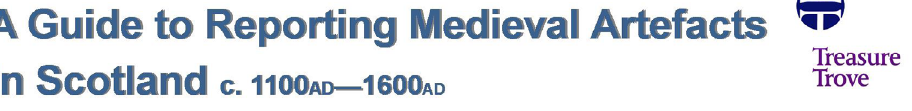
Fig. 1 Treasure Trove Guide to Reporting Medieval Artefacts in Scotland 1100 –